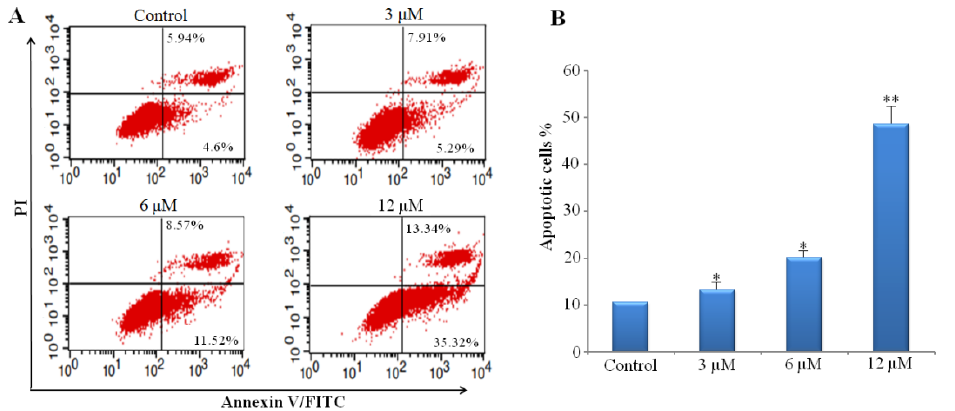
Figure 5. Compound 8f induced MCF-7 cells apoptosis. ( A ) MCF-7 cells were co-cultured with compound 8f (0, 3, 6 and 12 μ M) for 24 h and then stained with Annexin V-FITC and PI. ( B ) Data were revealed as the means ± SD for independent tests in triplicate. * p < 0.05, ** p < 0.01 vs. control ( 8f 0 μ M) group.